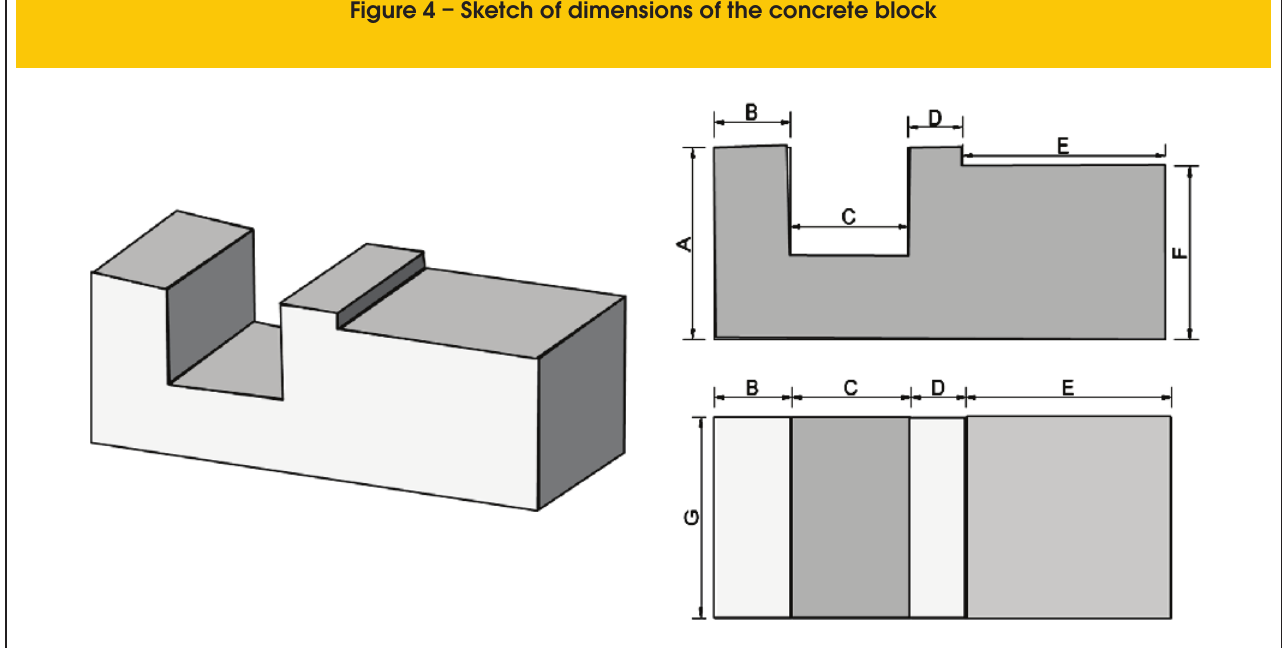
Figure 4 – Sketch of dimensions of the concrete